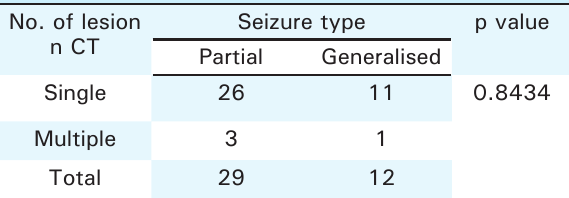
Table 4. Association between the type of seizure and the number of lesion in CT